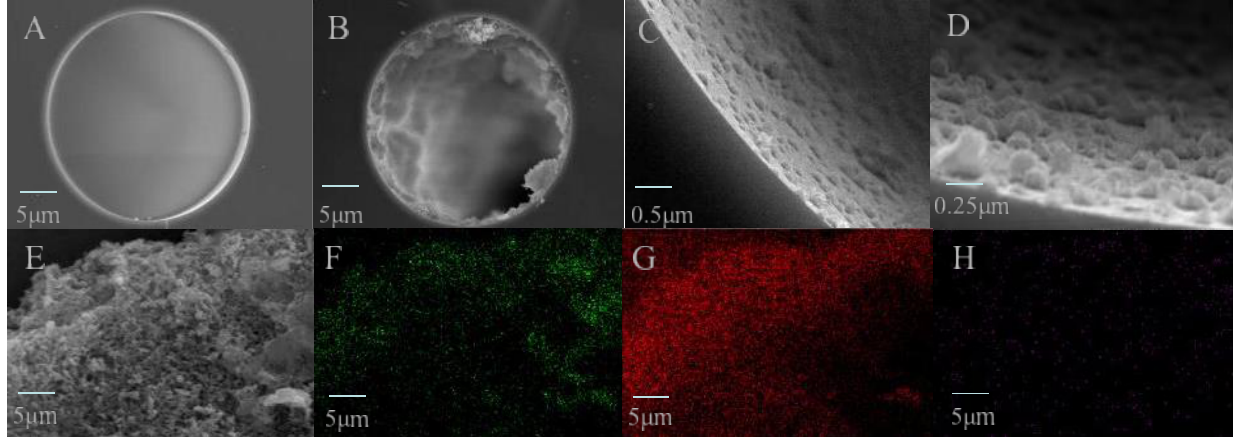
Figure 3. SEM images for the cross section of the TpBD COF immobilized capillary. ( A ) The bare column ( × 1.0 k), ( B – E ) TpBD COF immobilized capillary ( × 1.0 k, × 10.0 k and × 20.0 k) and ( E – H ) EDS images for the stationary phase in the TpBD COF immobilized capillary ( × 4.0 k, green, red and purple dots represent C, O and N atoms,